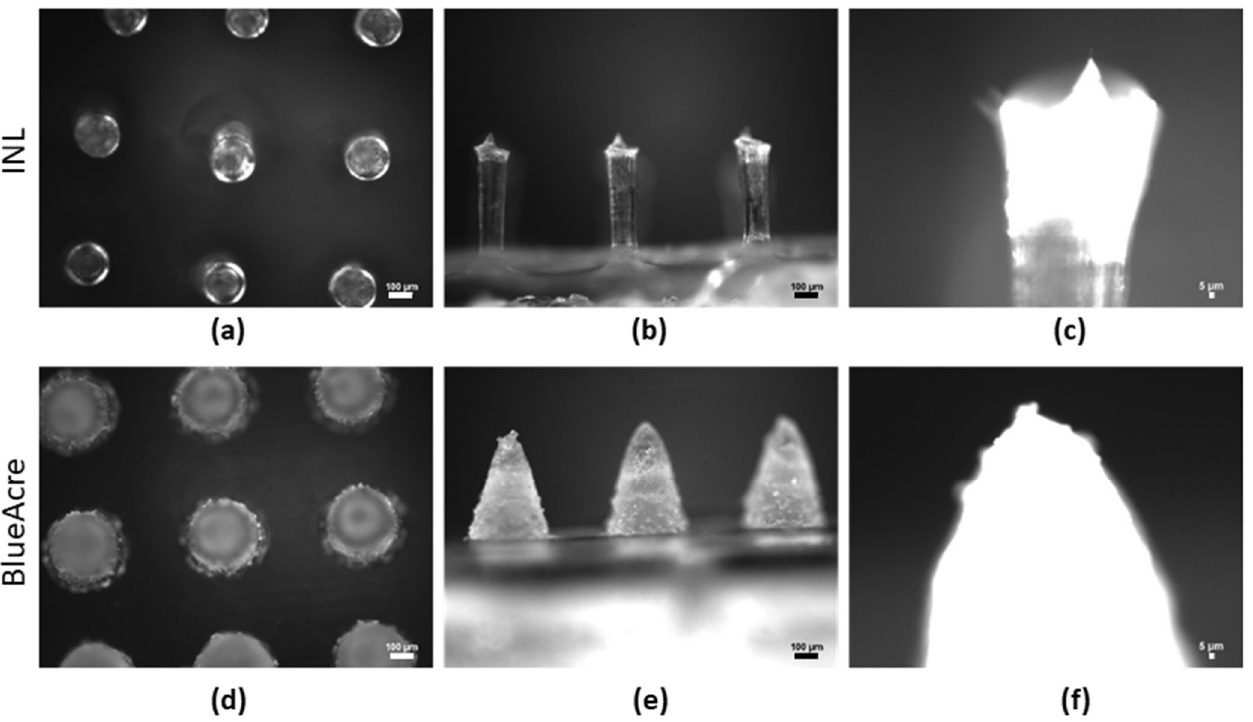
Figure 3. Top and lateral view of the INL and BlueAcre MNs fabricated using PVA dissolved in SM buffer with glycerol 0.1% ( v / v ) and visualized with a wide-field upright optical microscope. ( a , d ) top view imaged with × 5 objective; ( b , e ) lateral view imaged with × 5 objective, ( c , f ) lateral view of the needle tip with × 20 objective. The ruler in ( a , b , d , e ) is 100 µ m, and in ( c , f ) is 5 µ m. The PVA G MNs had average heights and base diameters of 518.16 ± 48.06 µ m and 205.00 ± 13.54 µ m for the INL MNs, and 514.86 ± 7.42 µ m and 294.78 ± 14.27 µ m for